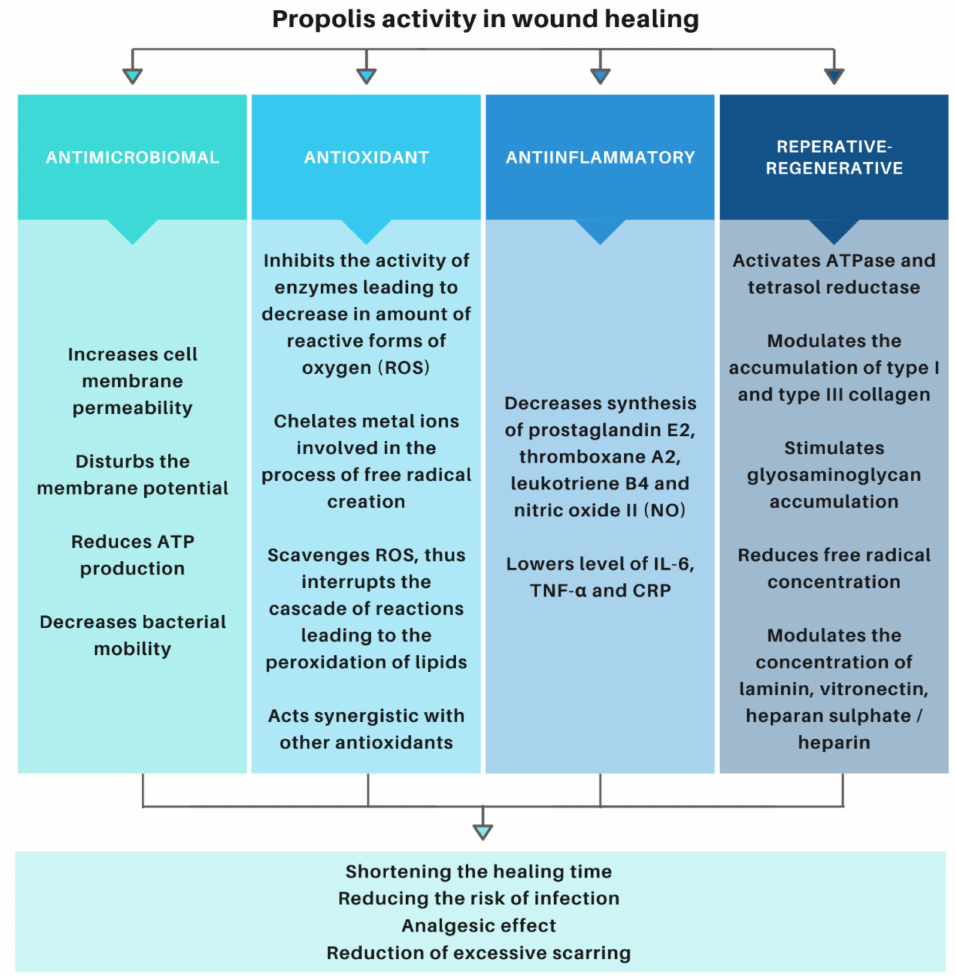
Figure 1. Mechanism of propolis action in wound